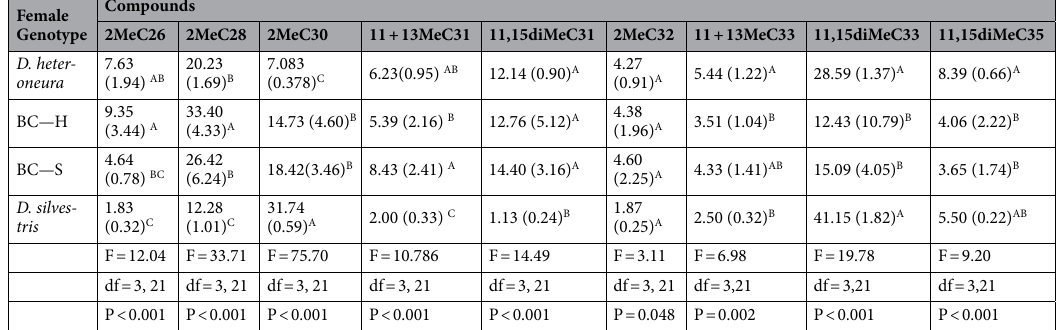
Table 3. Analysis of variance (ANOVA) of the major CHCs of D. heteroneura (n = 5), D. silvestris (n = 5), and backcross females: BC—H backcross to D. heteroneura (n = 10, and BC—S backcross to D. silvestris (n = 5). The mean percentage of each compound for each group of females with the standard deviation in parentheses is reported. Means that do not share a letter are significantly different following Tukey’s multiple comparison tests (P <